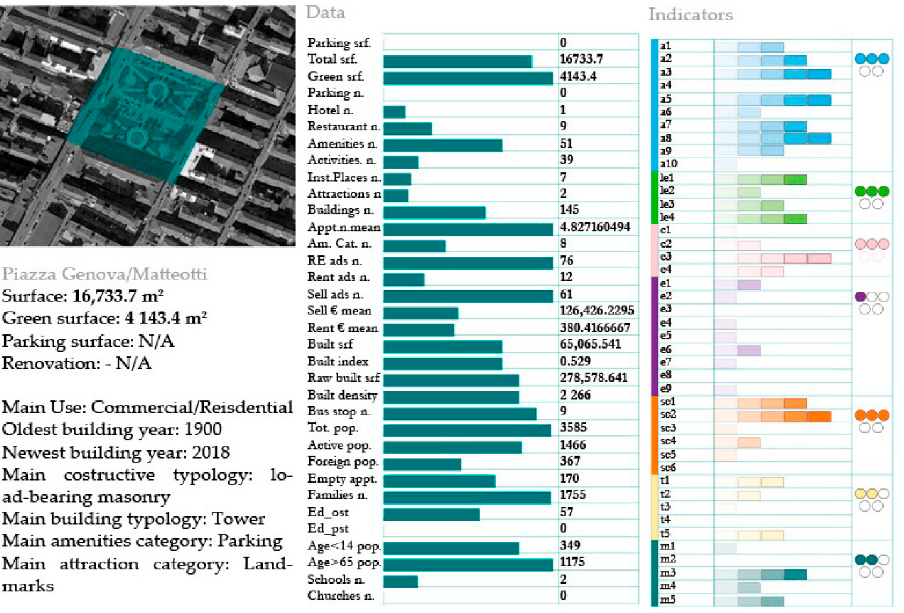
Figure 6. Taking Piazza Genova/Matteotti as an example, the collected data have been aggregated as a thematic set of indicators, moving from the first mapping phase to the evaluative one, and laying a foundation for subsequent strategic design elaboration [Source: Authors, Google Satellite].